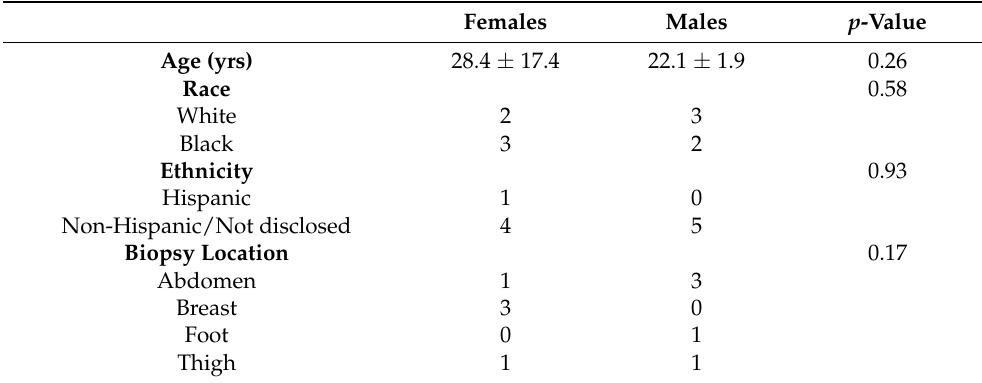
Table 1. Sample source